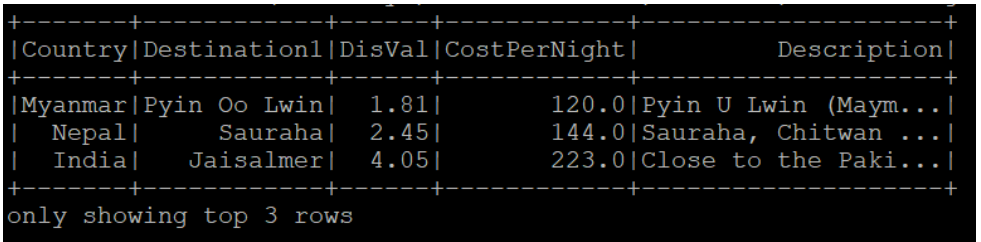
Figure 26. Example 2 of destination suggestions from thematic TRS.